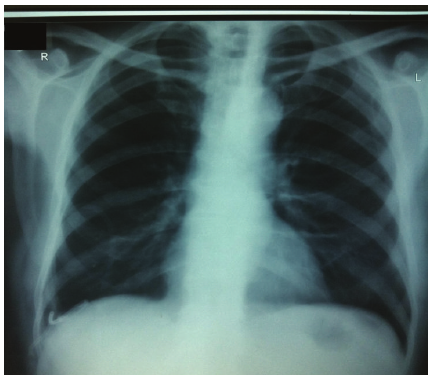
Figure 2: Chest X-ray of the same patient showing pigtail catheter in place with no effusion.